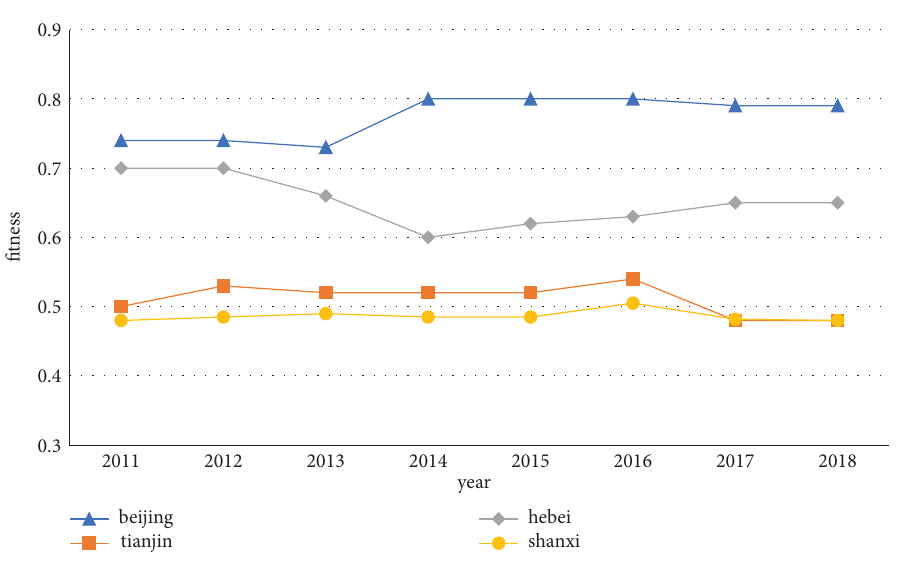
Figure 4: Comparison of changes in niche suitability from 2011 to